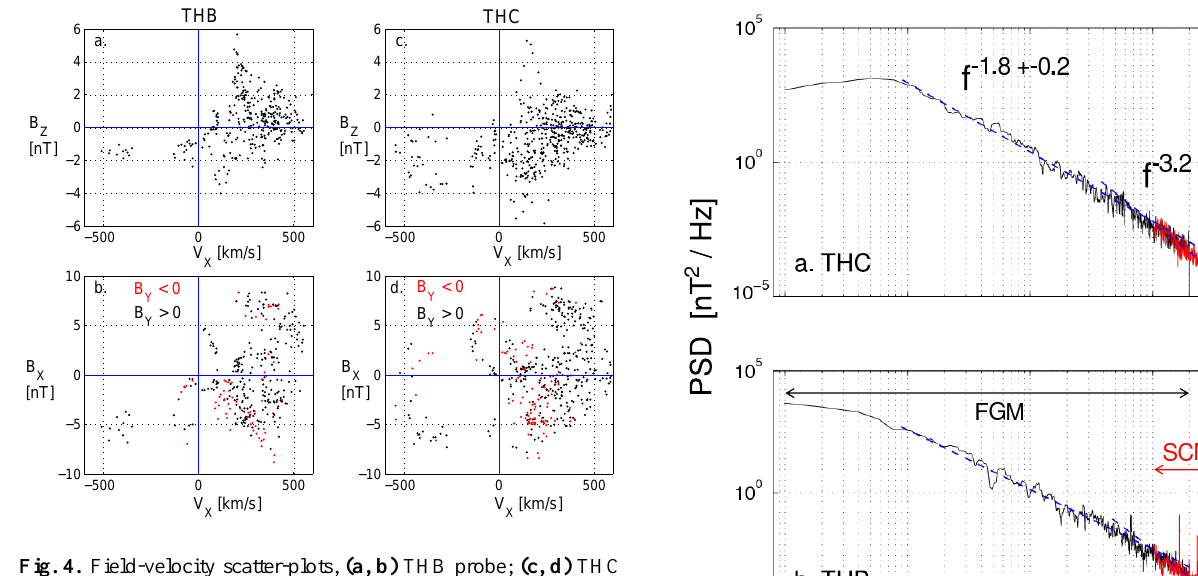
Fig. 4. Field-velocity scatter-plots, (a, b) THB probe; (c, d) THC probe; (a) and (c) V X versus B Z ; (b) and (d) V X versus B X ; B Y < 0 – red points; B Y > 0 – black points.